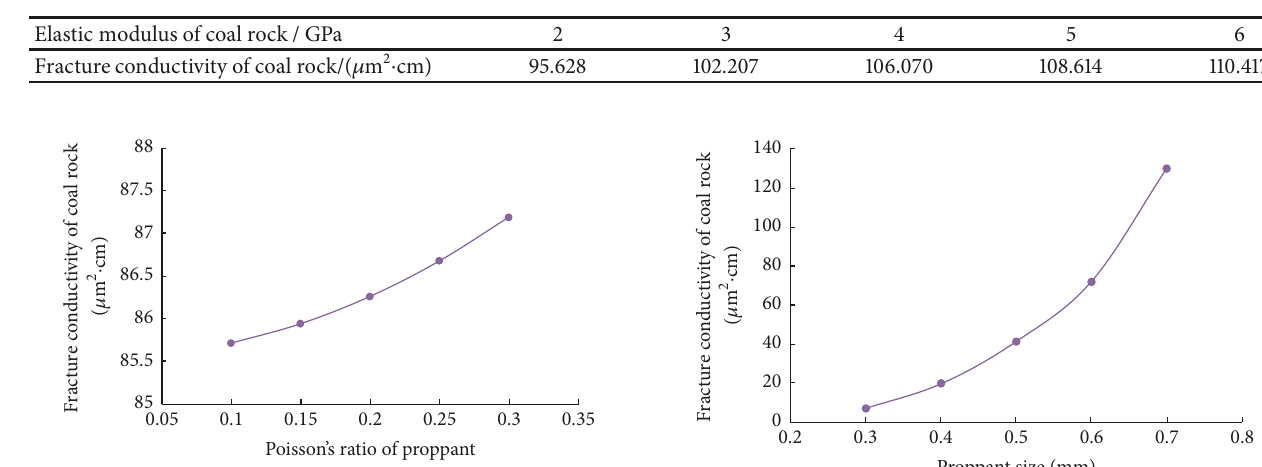
Table 4: Fracture conductivity under different elastic modulus of coal rock.